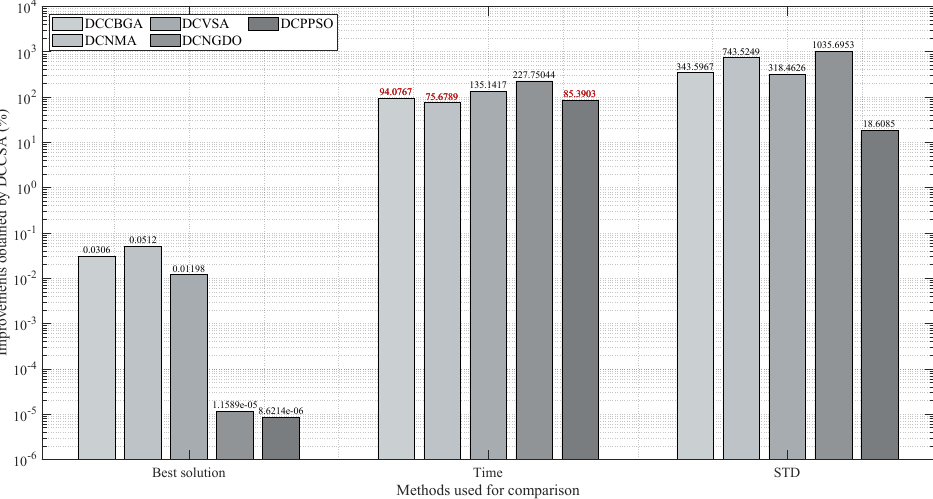
Figure 7. Improvements obtained by the DCCSA in the 69-node test